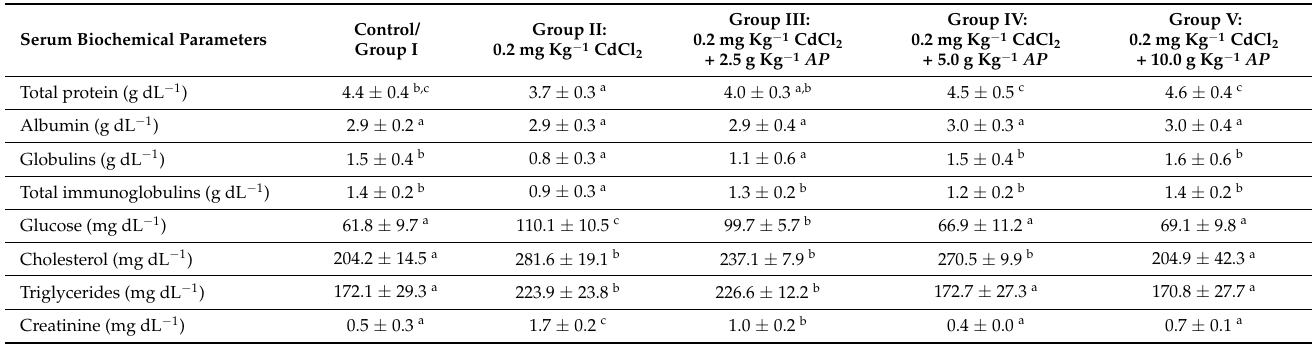
Table 2. Results regarding analysis of serum biochemical